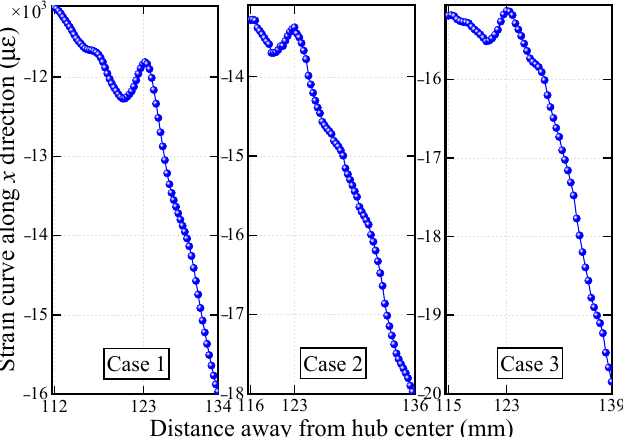
Figure 14. Strain curve of the damaged region.